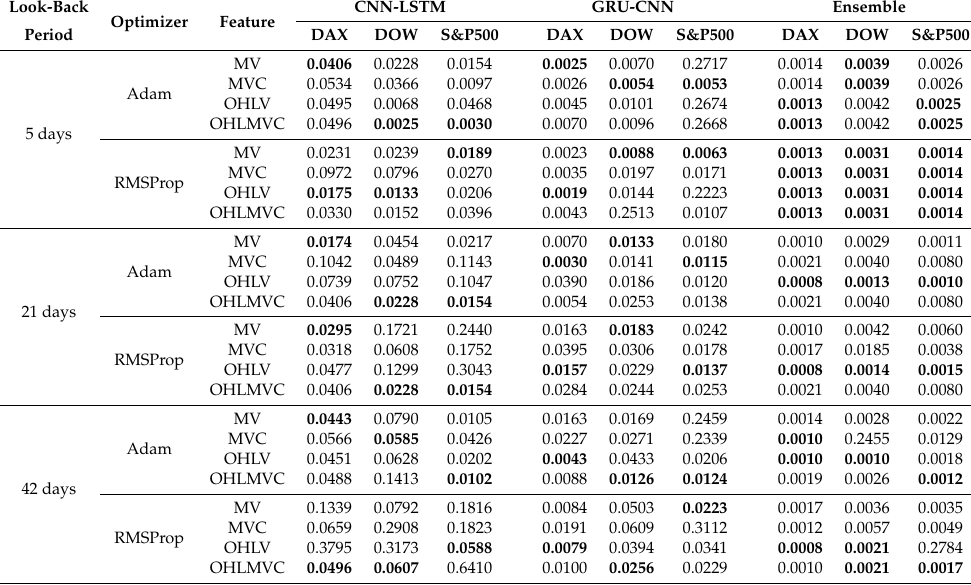
Table 4. Comparison of different optimizers and features in terms of average MSE over the three periods for one-time-step prediction. Look-Back CNN-LSTM GRU-CNN Ensemble Optimizer Feature Period